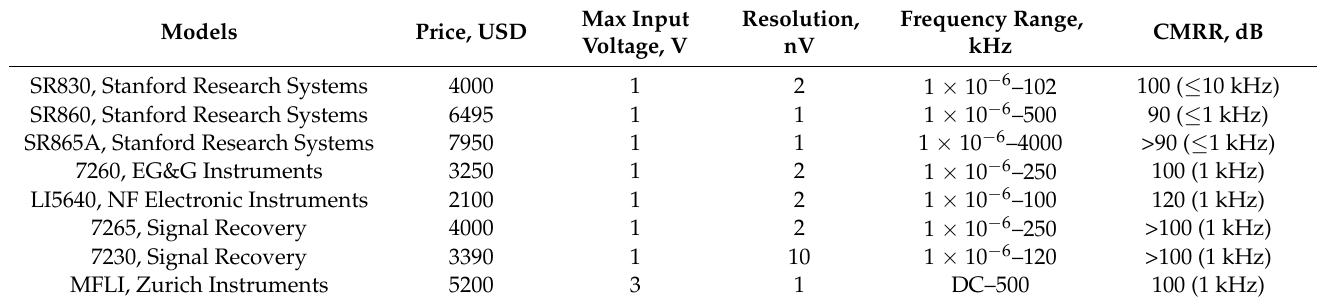
Table 1. Specifications for commercially-available lock-in amplifiers.